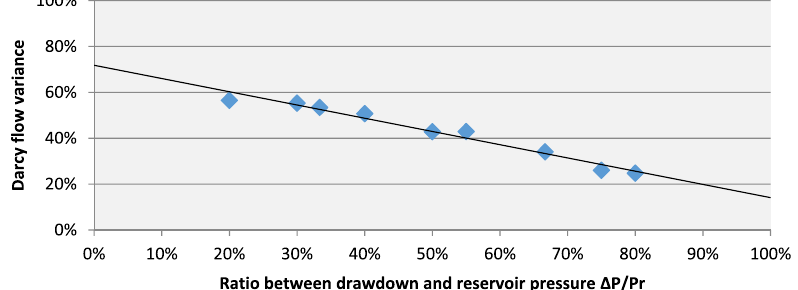
Fig. 6 Sensitivity of reservoir pressure and drawdown on Darcy’s flow